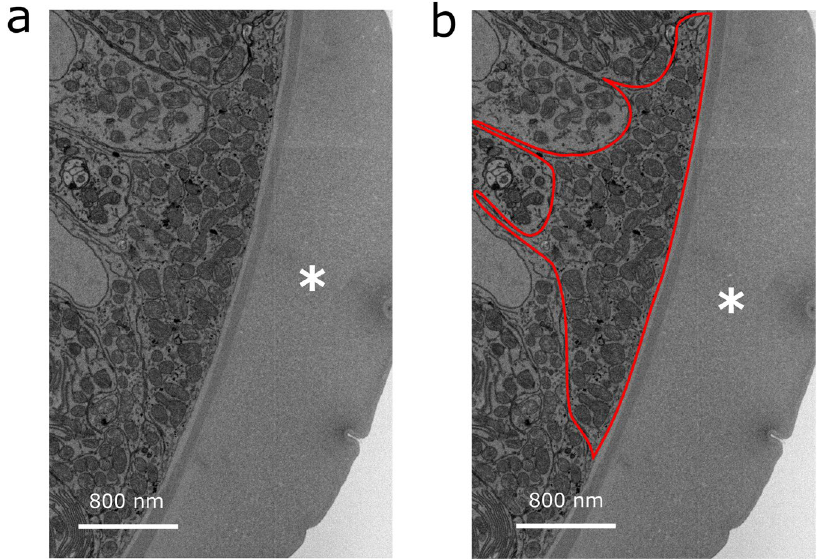
Figure 4. Electron micrograph showing the tissues underlying the cuticular inflation. T. muris were extracted at day 35 PI from infected mice and using a correlative imaging workflow, regions of interest were captured by CT-guided SBF-SEM carried out on the cuticular inflations in worms extracted from the host gut. ( a , b ) show the ultrastructure beneath the cuticular inflations. In particular, a cell is present with a high number of mitochondria (highlighted in red, ( b ), directly underneath the inflation ( * ). The cell is not bacillary, and it lacks a folded apical